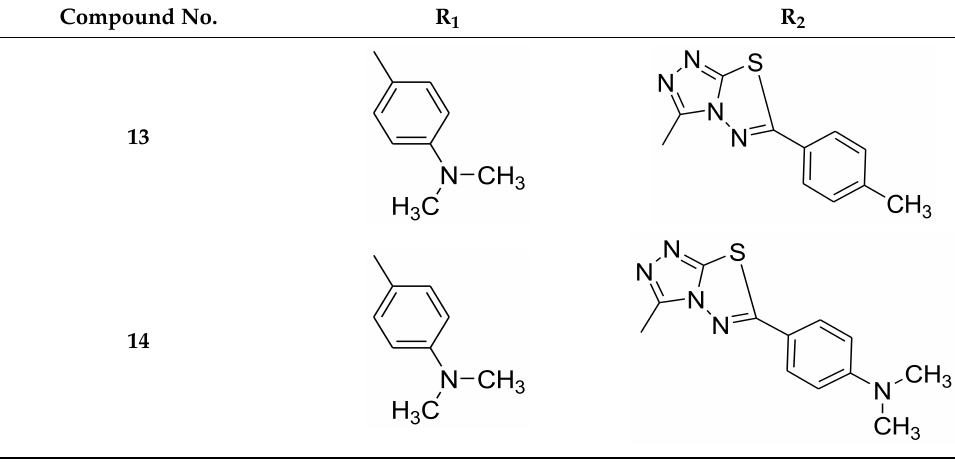
Table 1. Cont. Compound